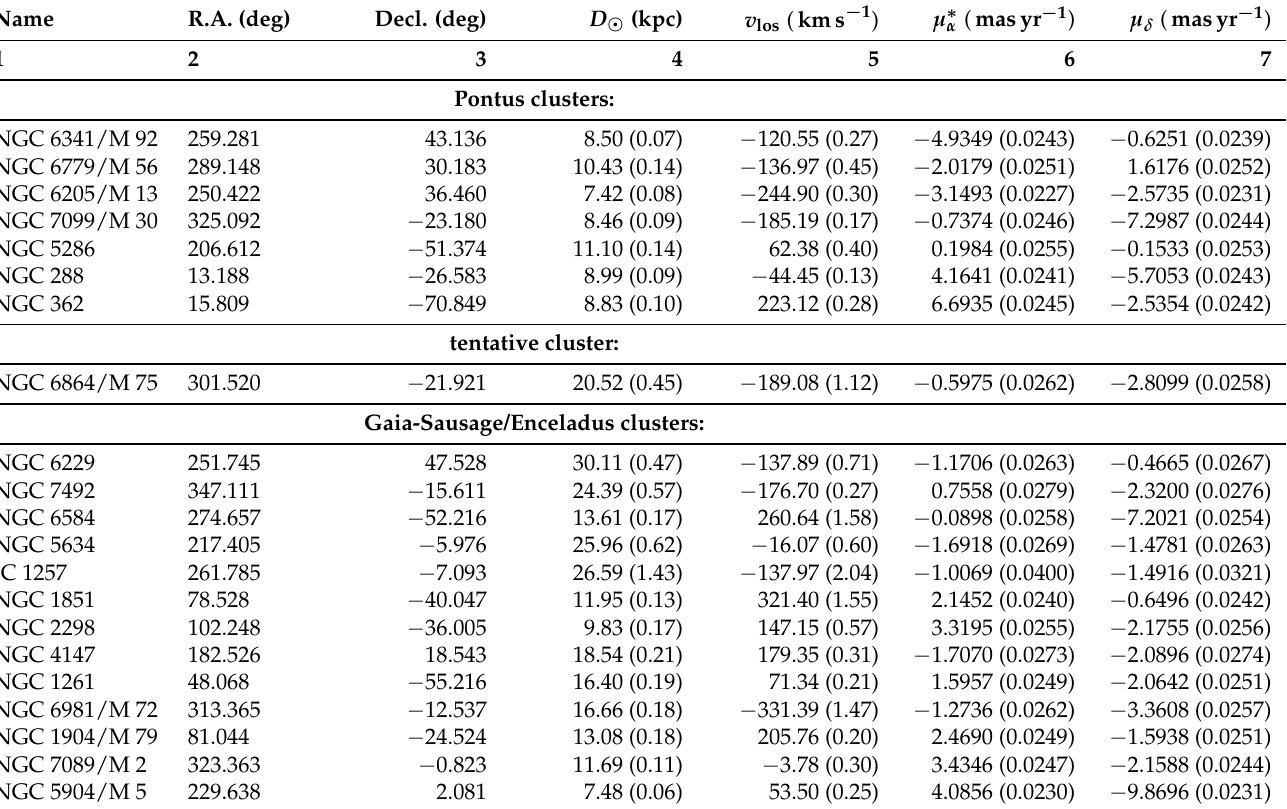
Table 1. Heliocentric parameters of globular